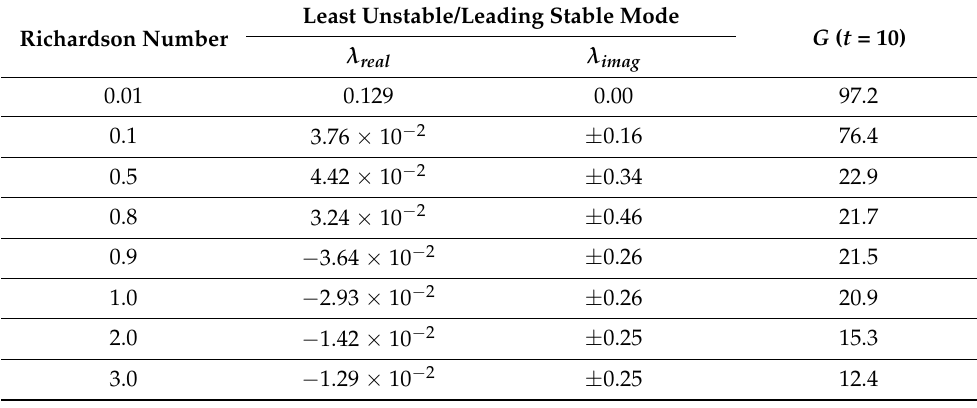
Table 3. The variations of the leading eigenvalues and values of amplification function, G , (at an arbitrary time t = 10) with increasing Richardson number for α = 0.5, β = 0, R e = 1000 (2D case).